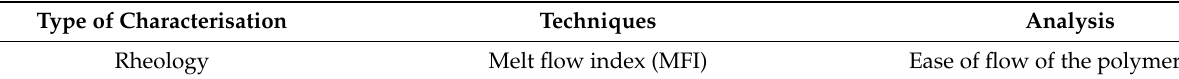
Table 1. List of LTW pre-and post-processing techniques for the analysis of SC